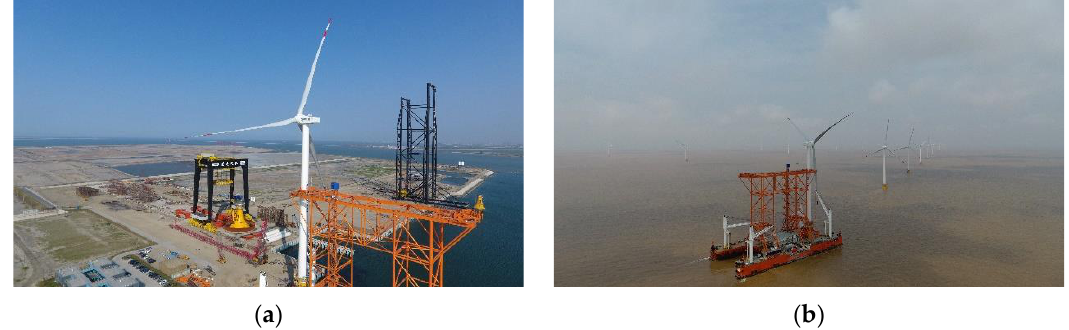
Figure 2. ( a ) Onshore integral construction ( b ) offshore one-step installation.